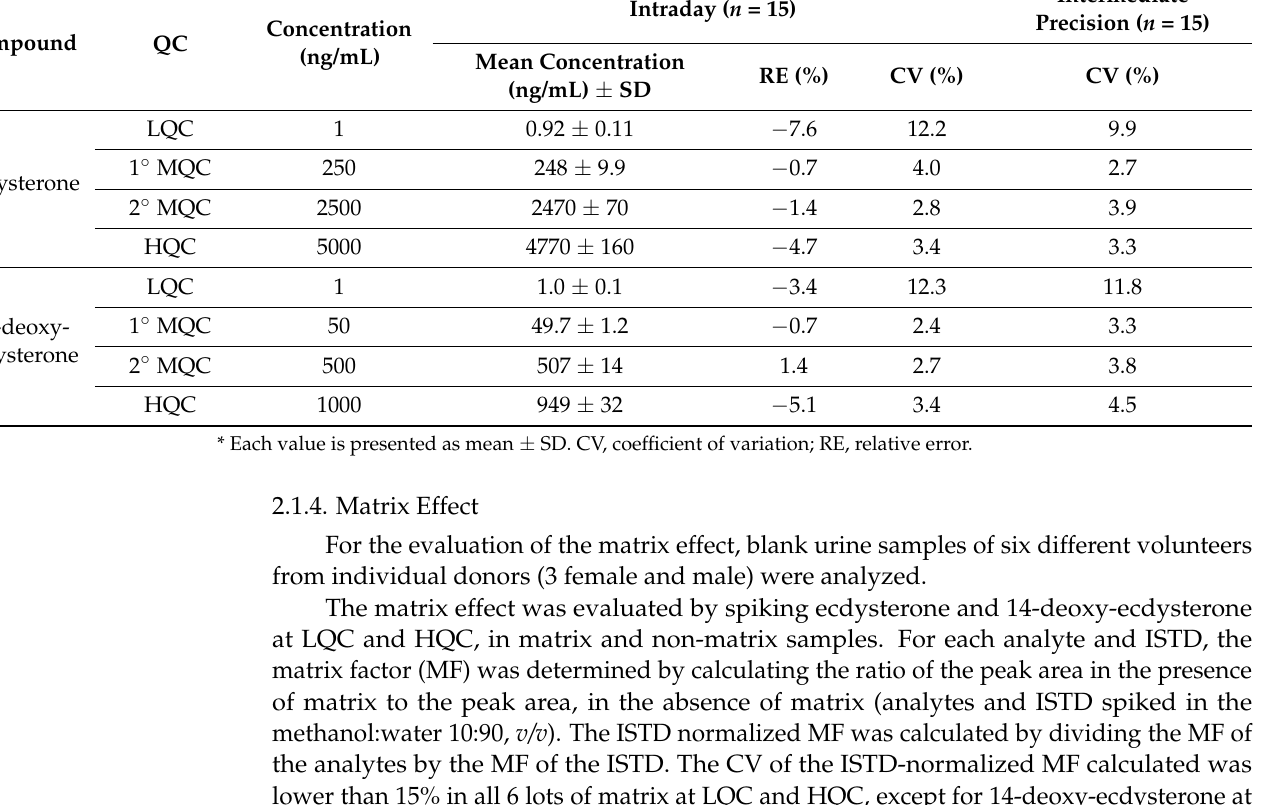
Table 2. Intraday accuracy, intraday precision and intermediate precision of ecdysterone and 14-deoxy-ecdysterone *.